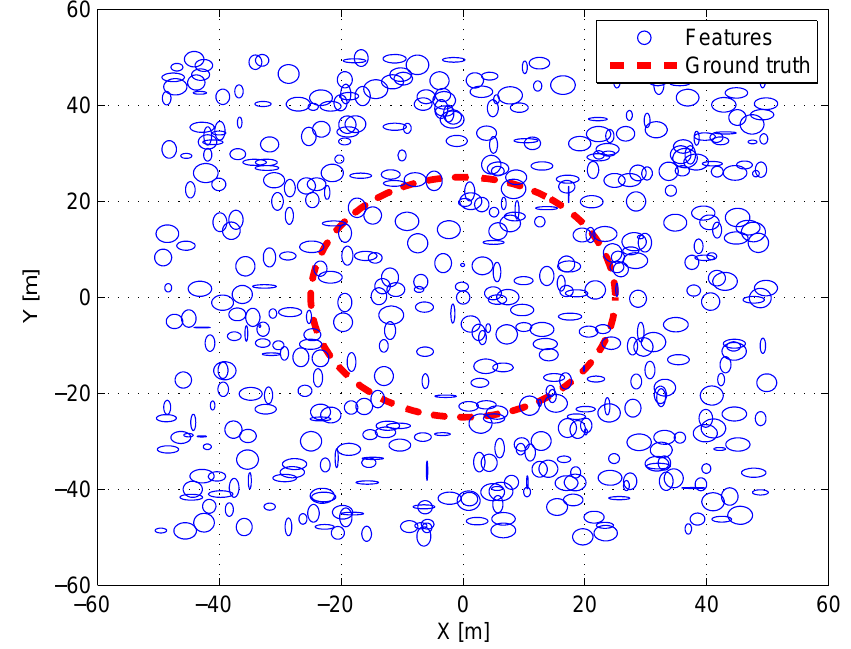
Figure 3. Top view of the simulation environment. Blue circles denote the covariance of features and the red dots denote the ground truth of the robot’s